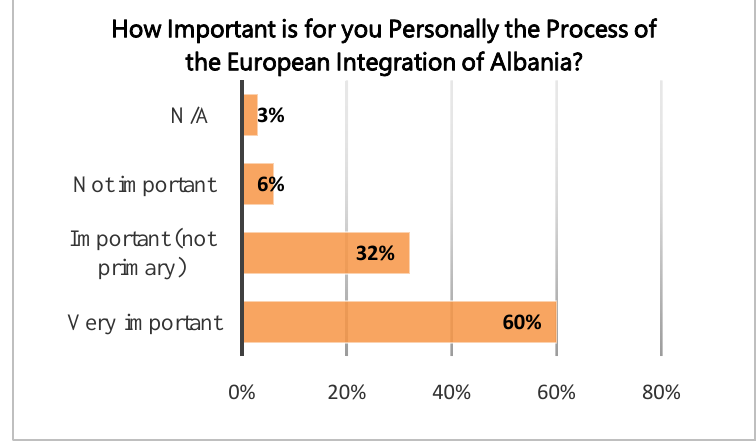
Figure 2: The Albanian Public Support for the European Integration (Source: AIIS